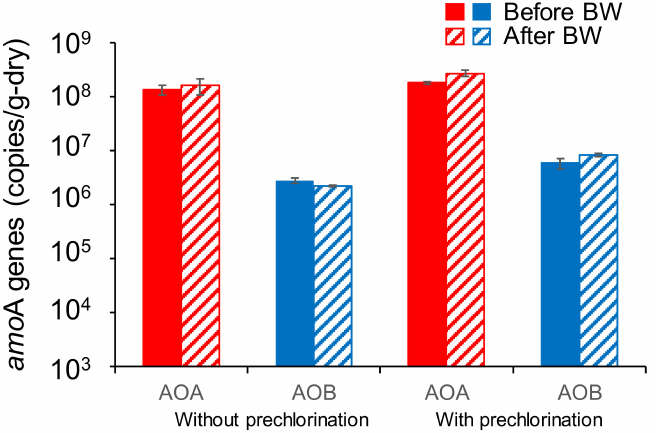
Figure 3. Abundances of AOA and AOB on the GAC before (solid bar) and after (bar with slash) backwashing in the sampling time of “without prechlorination” and “with prechlorination”. AOA: ammonia-oxidizing archaea, AOB: ammonia-oxidizing bacteria, and error bar: the standard